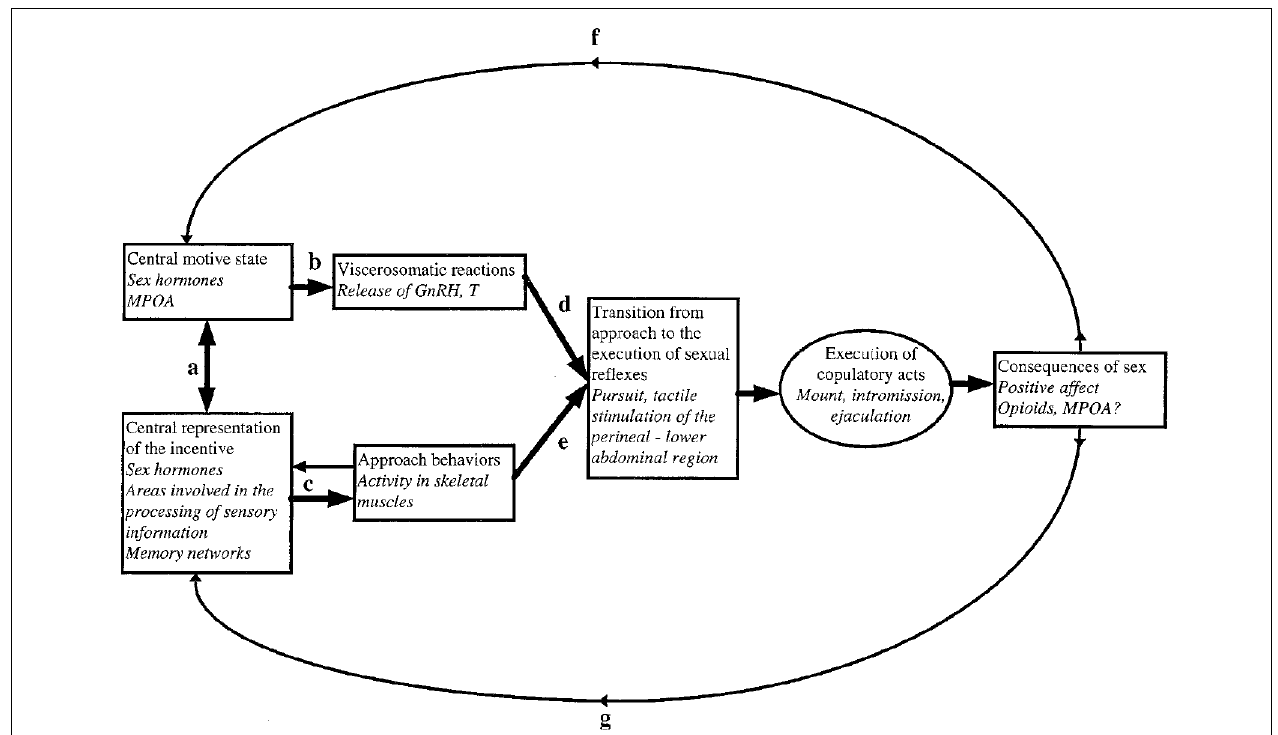
FIGURE 1 | A model for sexual incentive motivation. The text in italics represents the example of the male rat. (a) A reciprocal excitatory relationship functioning in such a way that the central motive state enhances the sensory system’s sensibility to stimuli with sexual significance. When such stimuli are perceived, the sensory system excites the central motive state which in turn further sensibilizes the sensory system, i.e., the relationship is one of reciprocal positive feedback. (b) At a certain threshold level of activity, the central motive state engages a series of viscerosomatic activities preparing the subject for sexual interaction. (c) The appropriate environmental stimuli activate motor patterns that bring the subject in contact with the source of stimulation. During approach, additional incentive stimuli may be encountered. These will be centrally represented and enhance the central motive state through (a) . (d,e) Provided that approach behaviors have been successful and that appropriate viscerosomatic reactions are being accomplished, the subject’s behavior may change from unconditioned or conditioned instrumental responses to the execution of sexual reflexes. These are activated by tactile stimulation of the perineal or lower abdominal region. If the subject is sexually inexperienced such stimulation is obtained accidentally. If the subject already has acquired sexual experience, then conditioned instrumental responses may facilitate the attainment of tactile stimulation necessary for activation of sexual reflexes. At the point of transition from approach to execution of copulatory reflexes, the behavioral sequence is aborted in the absence of tactile stimulation. In case that sexual reflexes indeed are activated, sex behavior will normally continue until ejaculation. (f) The positive affect induced by ejaculation will feed back to the central motive state where a short-lasting inhibitory system is activated. (g) At the same time, the positive affect and associated processes of reinforcement will strengthen the learning of associations between itself and environmental cues. These cues will acquire incentive properties in relation to the intensity of the positive affect that is experienced. For further details, see Ågmo (1999, 2011) and Paredes and Ågmo (2004). Reprinted from Ågmo (1999). Copyright (1999), with permission from